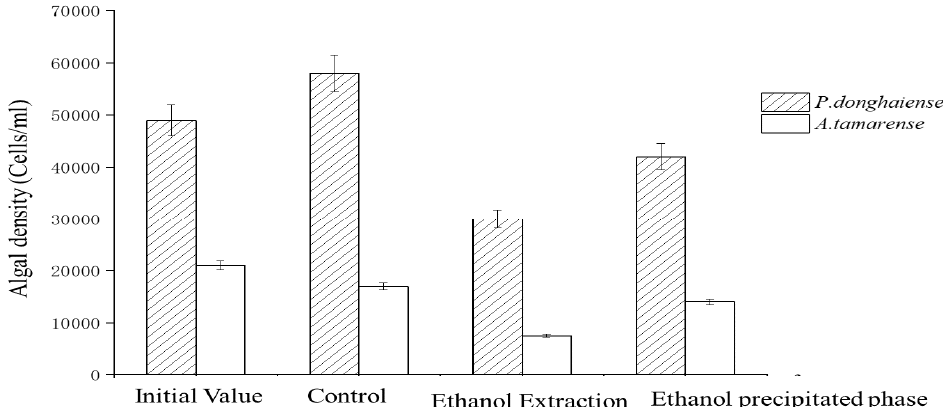
Figure 3. Inhibitory effect of the ethanol extraction phase and precipitation phase on algae growth.